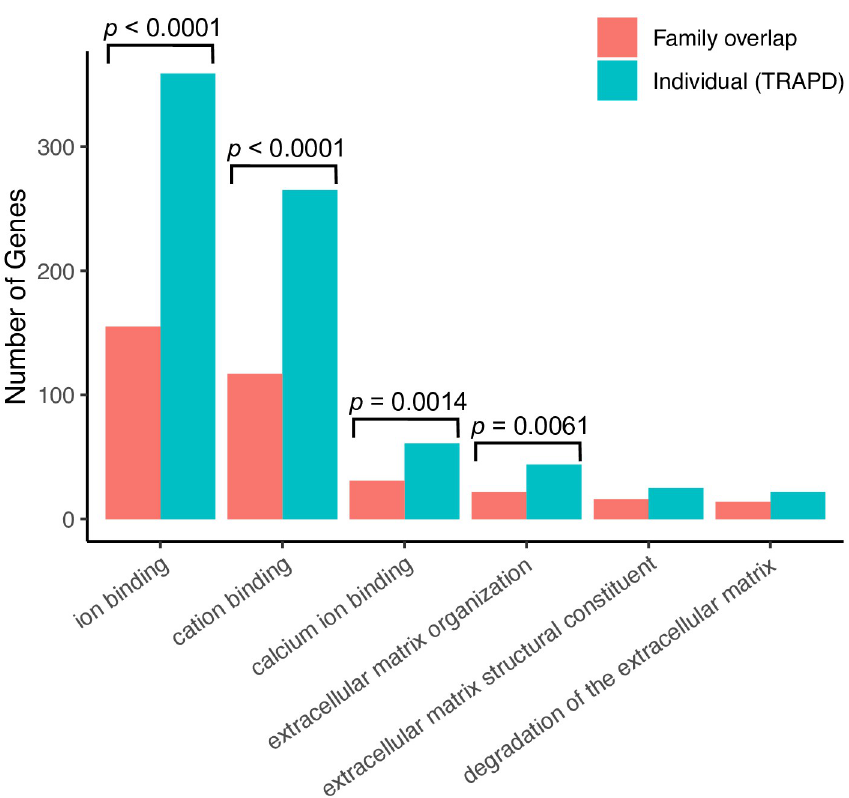
Fig 4. Common pathways enriched. Common pathway and ontology terms were found to be enriched for genes containing deleterious variants ( p < 0.01; Hypergeometric test) in both the family overlap (red) and TRAPD (blue) analysis. The number of genes with deleterious variants in each pathway or ontology term is shown. Pathway and ontology terms where there is a significant increase in the genes associated with that pathway in the TRAPD analysis compared to the overlap analysis are highlighted ( p < 0.05; one-sided 2-sample test for equality of proportions with continuity correction).